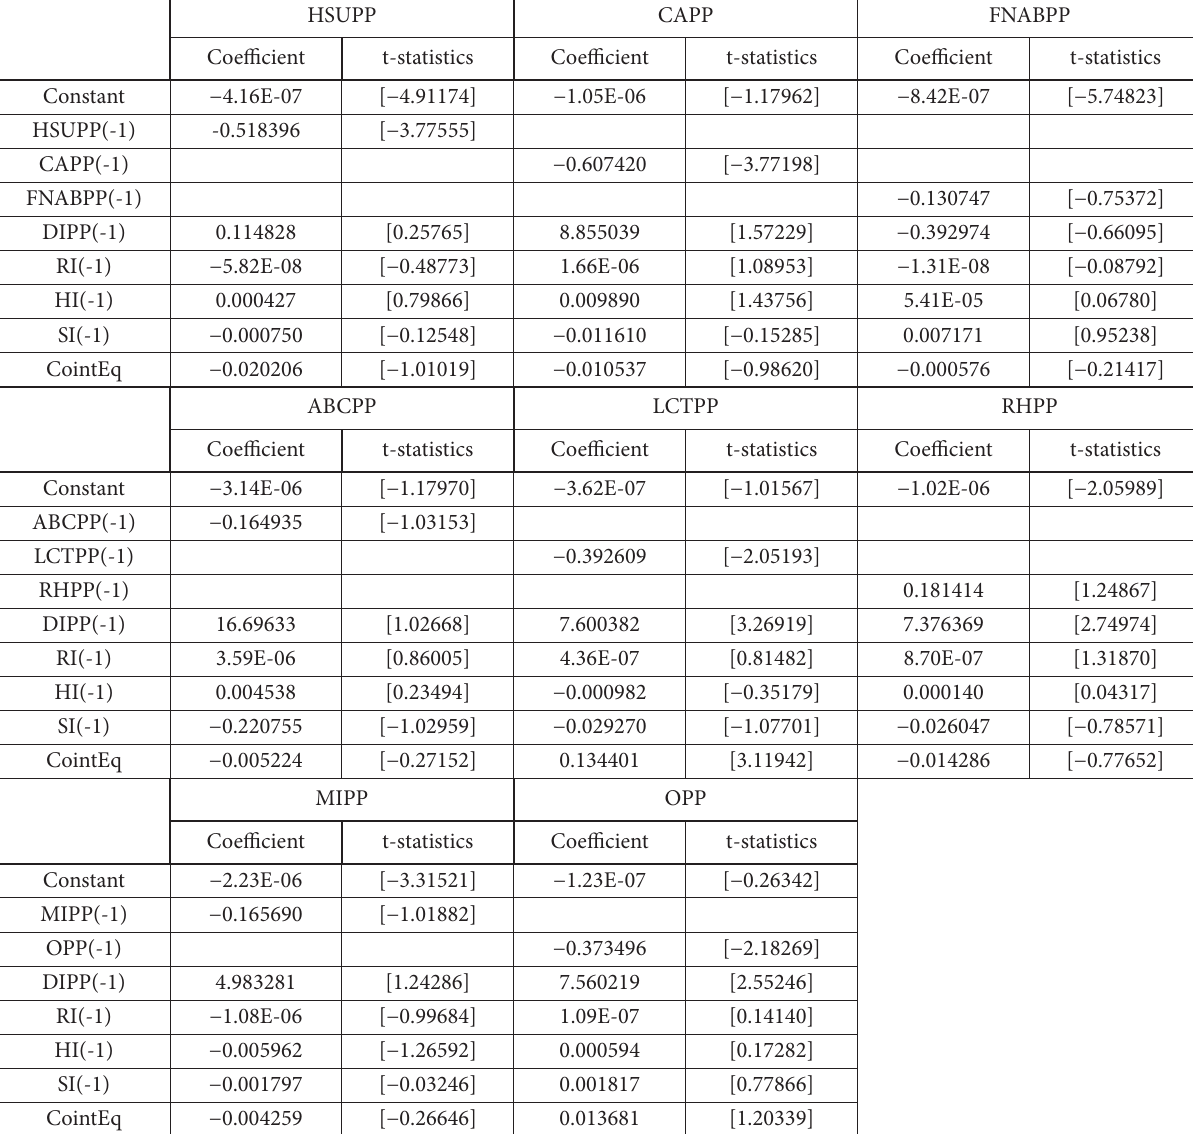
Table A2. Vector error correction model for sub-categories of non-durable goods consumption (short-term error